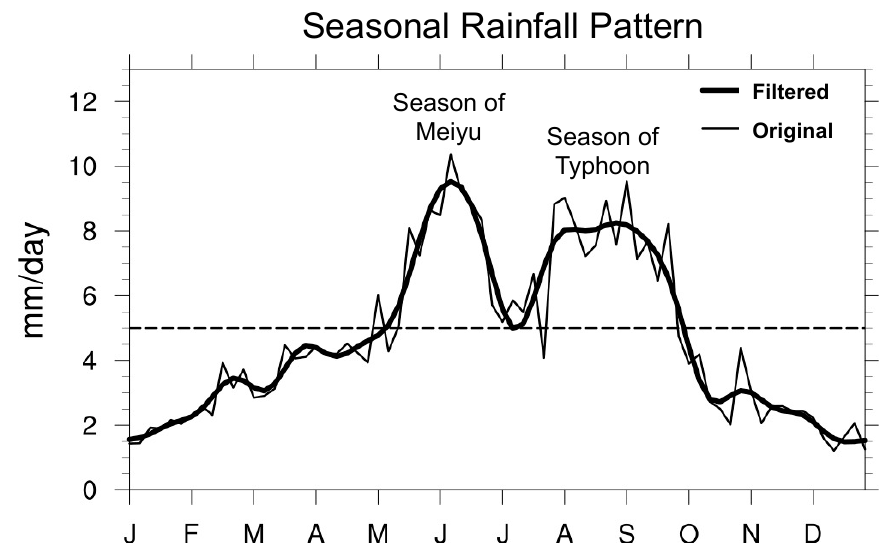
Figure 2. Schematic diagram of seasonal rainfall pattern and data filter (made by this study).